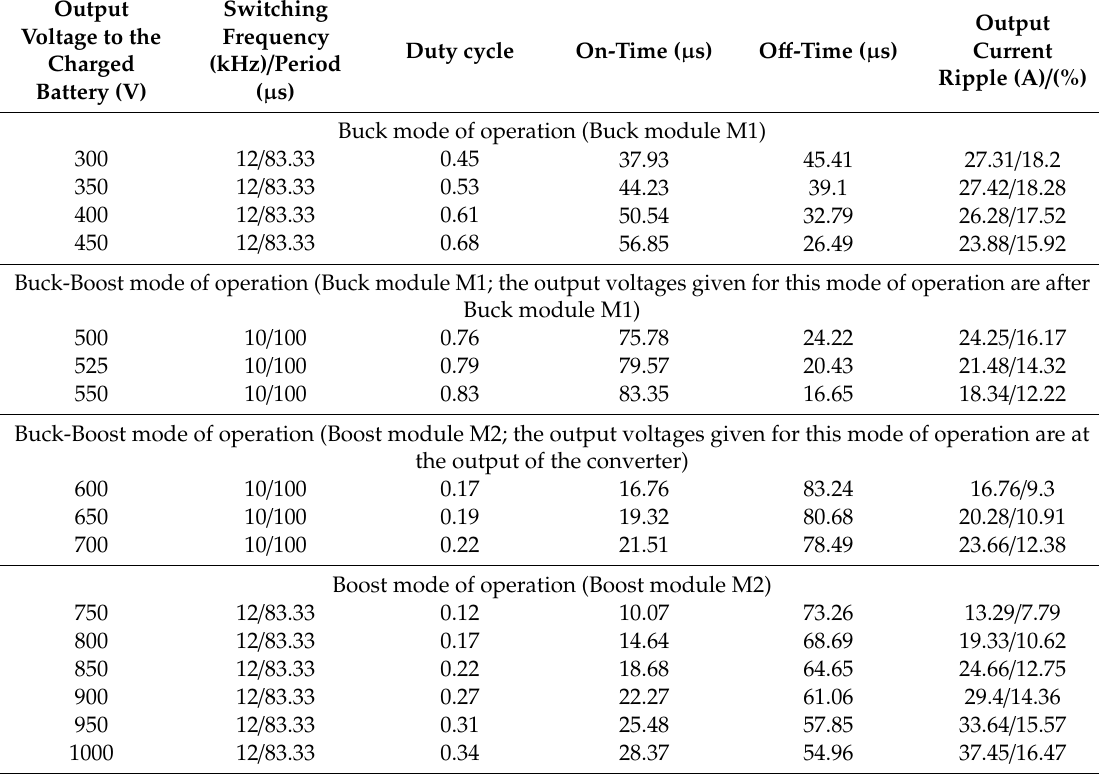
Figure 10. Buck-Boost operation mode power losses compensation with switching frequency reduction. 1–losses at 12 kHz switching frequency; 2–losses at 10 kHz switching frequency.